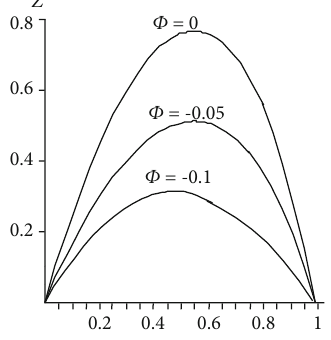
Figure 9: Velocity of Z when N = 0 : 5 , R = 1 : 5